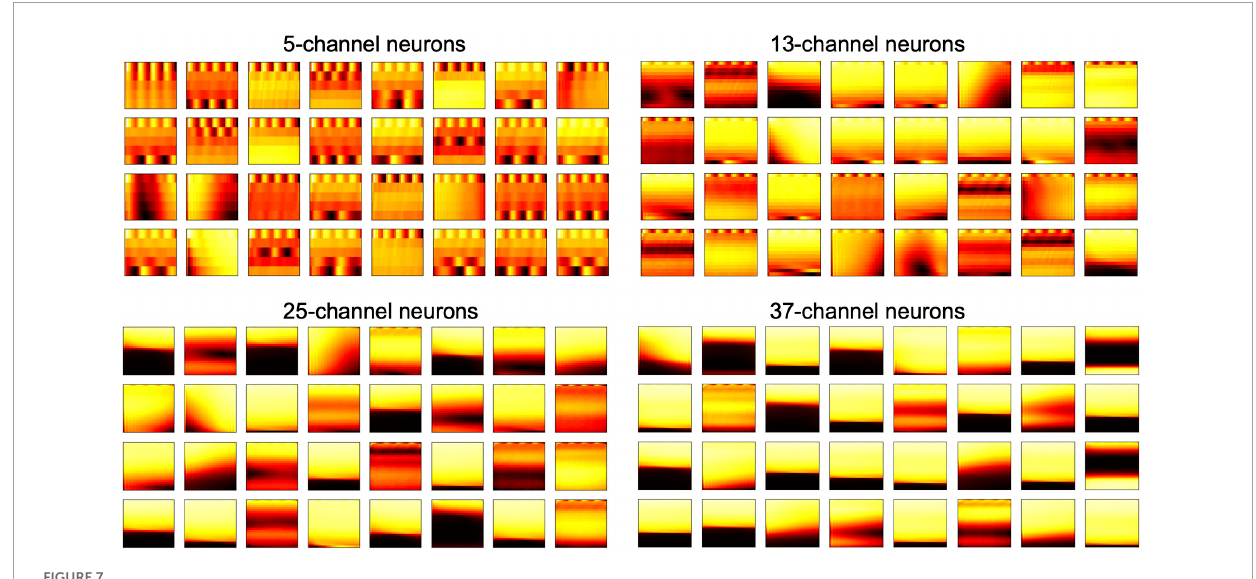
FIGURE7 32-neuron features for all the different 2-D neuron with different